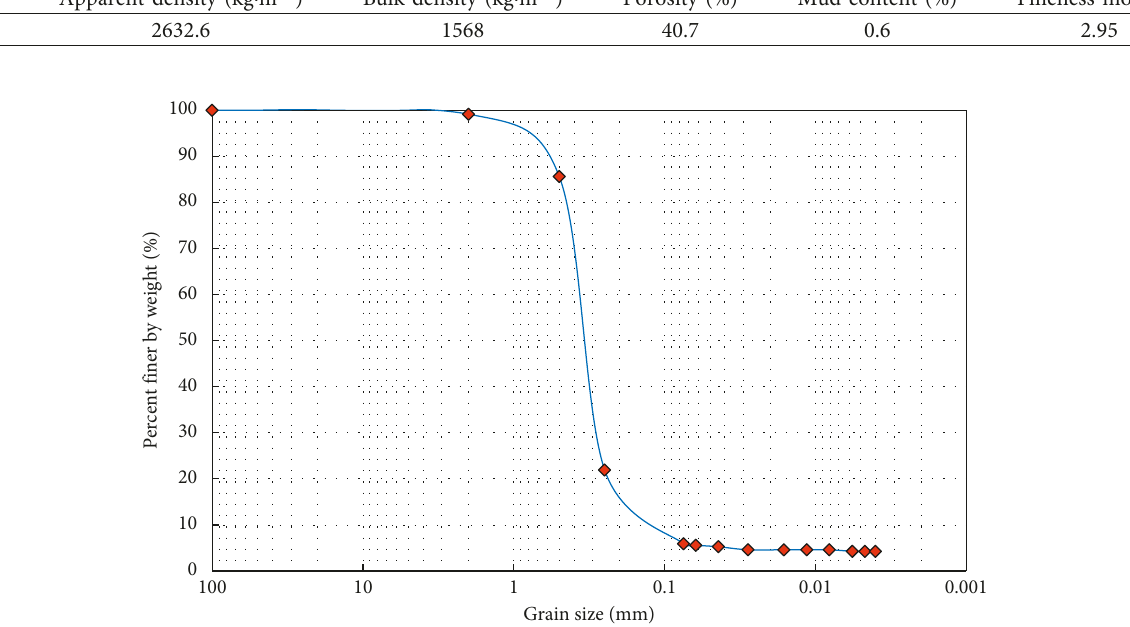
Figure 4: The grain-size distribution curve.